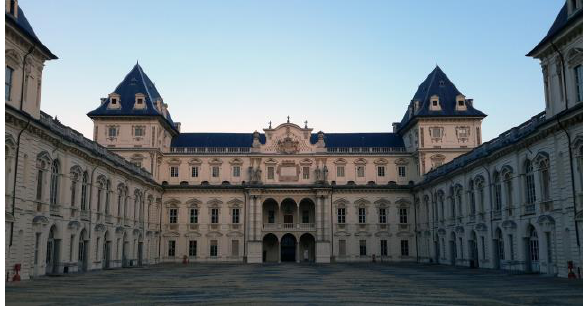
Figure 1. View of the Valentino Castle courtyard During the Second World War the central loggia underwent some extensive damage caused by the bombing, restoration works began between 1947 and 1948.